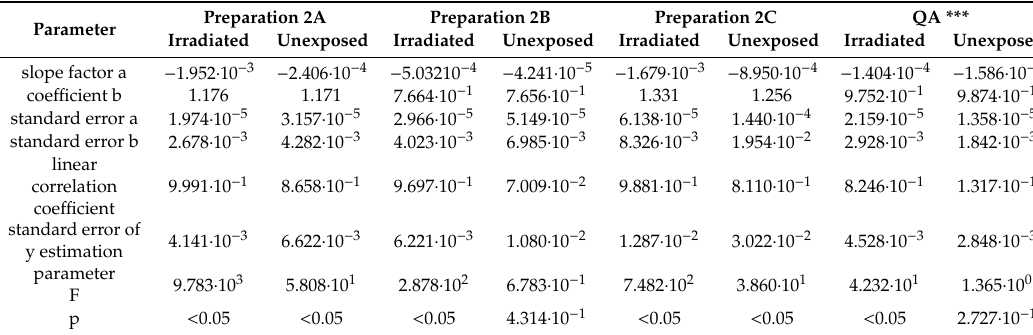
Table 3. Linear Correlation Parameters for the Obtained Data.